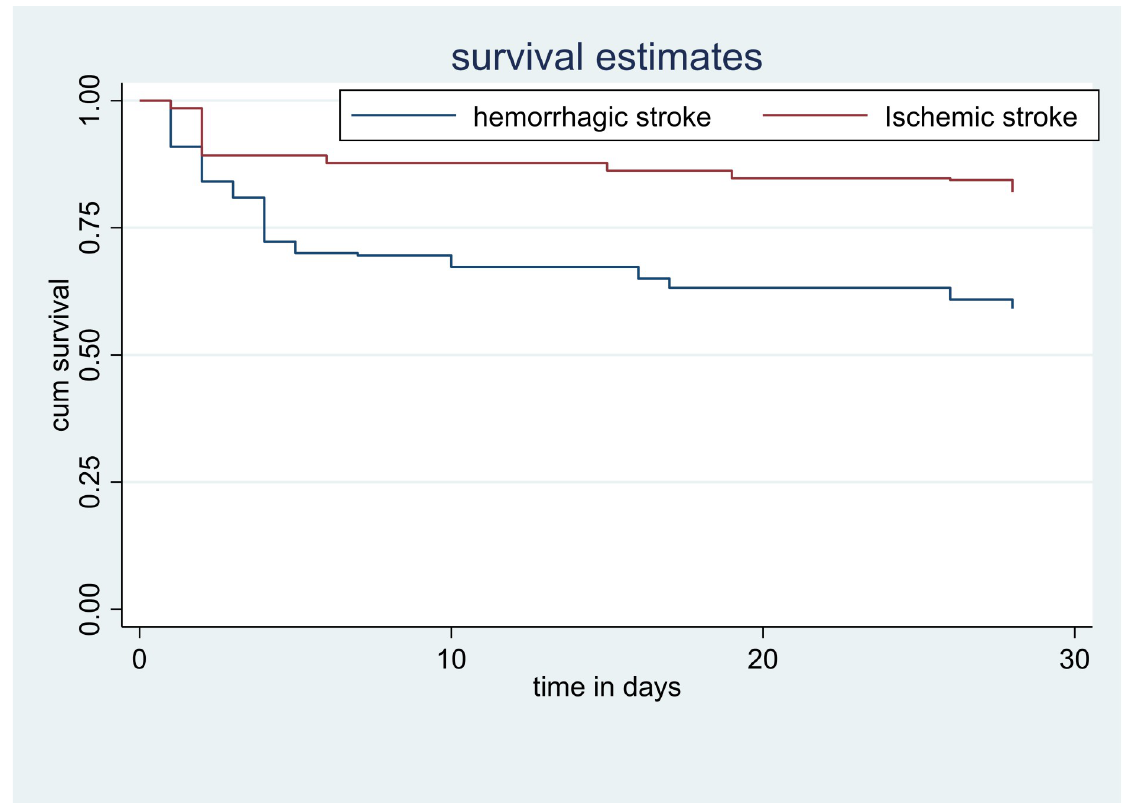
Fig 2. Survival probability curves derived from Log rank Kaplan Meier of fatality after 28 day follow up and type of stroke.